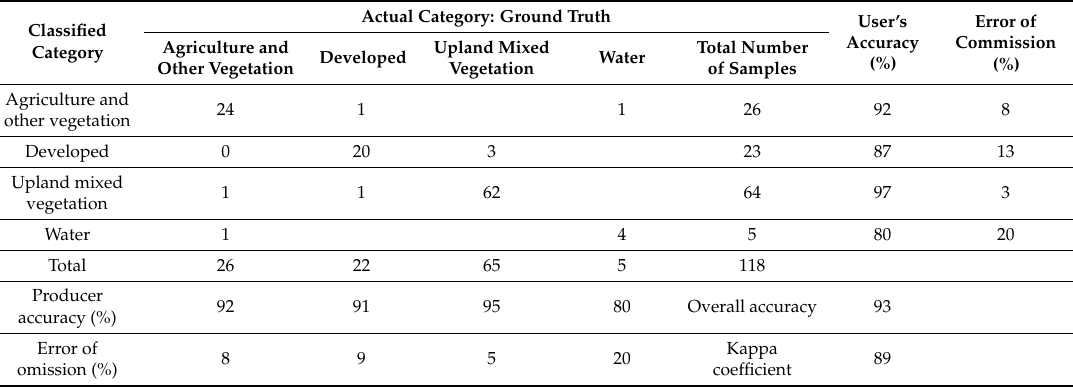
Table 3. Error matrix for 2015 image showing classification errors of omission and